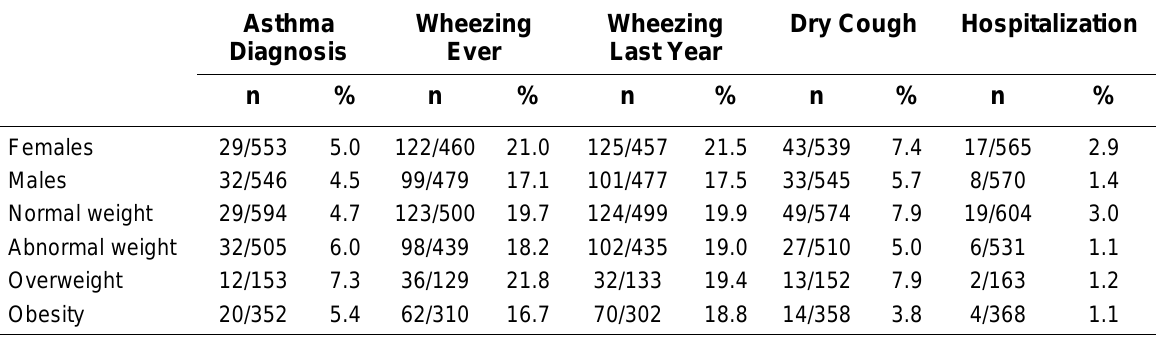
Prevalence of Overweight and Obesity